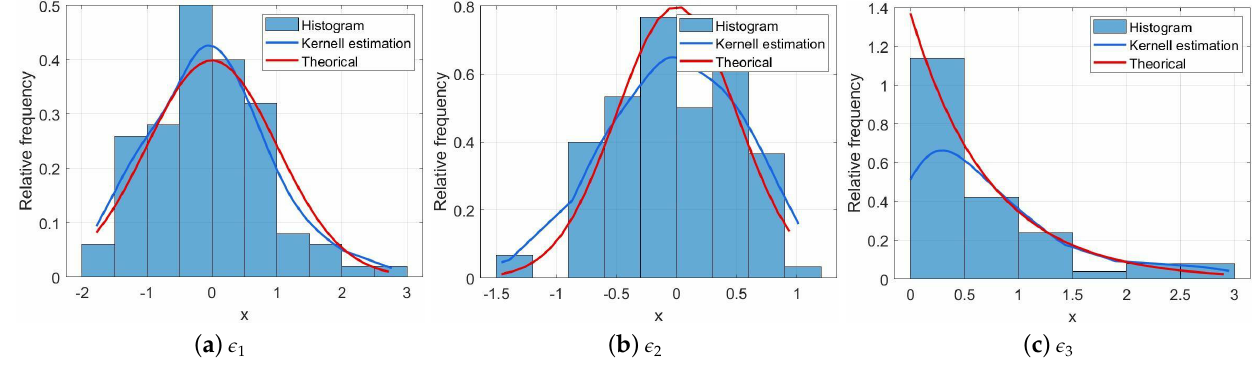
Figure 3. Kernel density estimation (KDE) and histogram of samples used for the model realizations compared with the theoretical density. ( a ) KDE, histogram, and theoretical density for (cid:101) 1 . ( b ) KDE, histogram, and theoretical density for (cid:101) 2 . ( c ) KDE, histogram, and theoretical density for (cid:101) 3 .